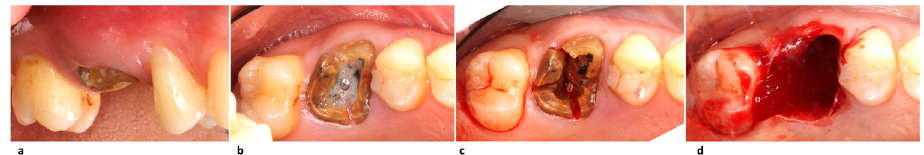
Figure 1. Less traumatic removal of the residual roots of the maxillary molar tooth. Preoperative area lateral ( a ) and occlusal views ( b ); residual roots separated from each other with one root per broken tooth segment ( c ); post-extractive site ( d ).